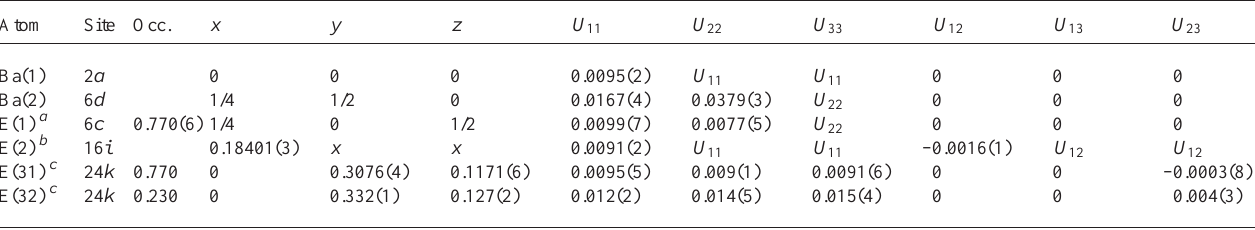
Table 4. Atomic coordinates and displacement parameters (in Å 2 )